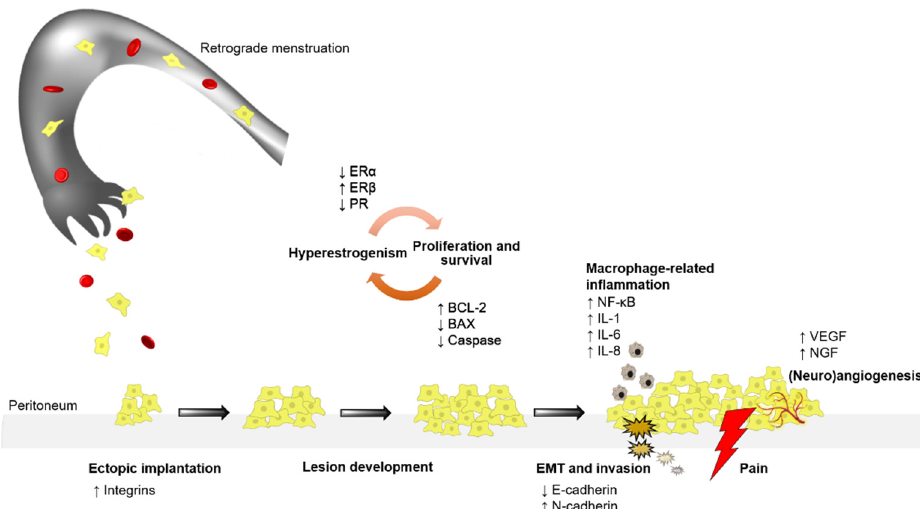
Figure 1. Summary of the mechanisms involved in endometriosis initiation and progression. Endometrial tissue/cells are carried by retrograde menstruation to ectopic locations (peritoneum), where high expression of integrins facilitates their implantation. The constant hyperestrogenism observed in endometriosis, followed by enhanced cell proliferation and survival, leads to lesion development and progression. At the same time, accumulating macrophages release a number of inflammatory mediators, thereby triggering the process of EMT, with the subsequent invasion and angiogenesis/neuroangiogenesis leading to lesion growth and the generation of pain symptoms in endometriosis patients.